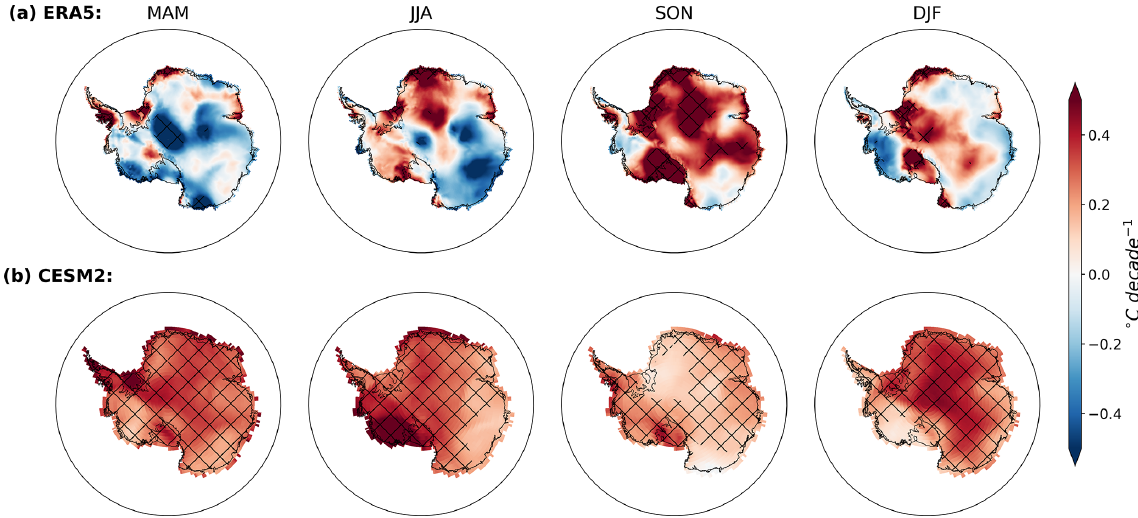
Figure 3. 1979–2015 seasonal temperature trends from (a) ERA5 and (b) CESM2. Cross-hatched areas represented regions where this trend is significant ( p < 0.05).